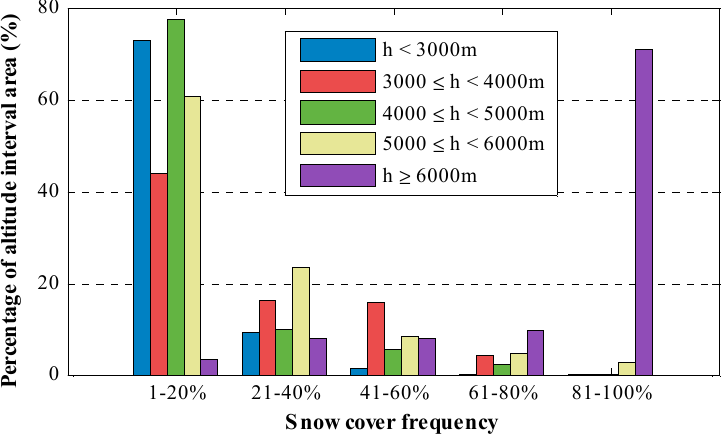
Figure 5. Frequency distributions of snow cover of five altitude intervals during 2001–2015.